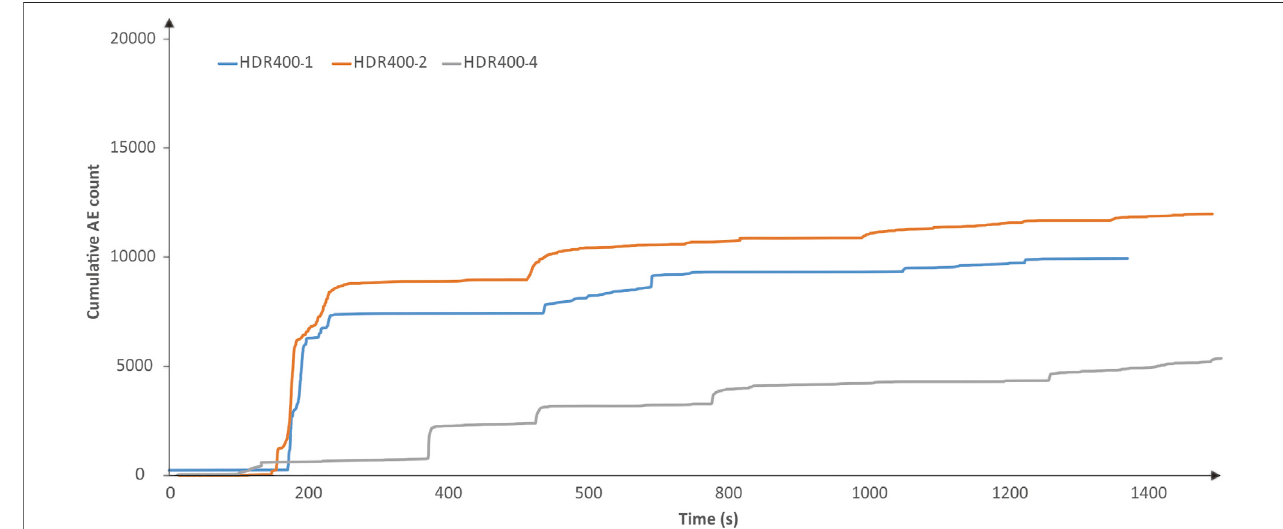
FIGURE 11 | Cumulative AE count over time.